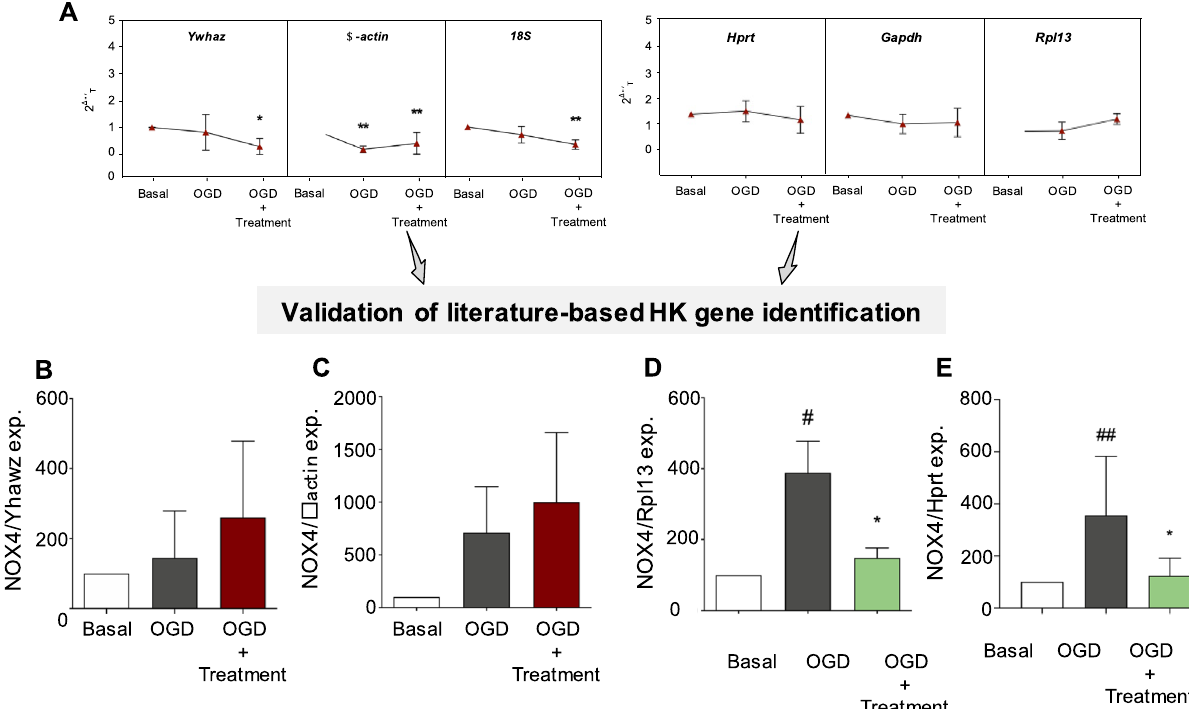
Figure 2. Opposing gene expression results are based on specific housekeeping gene selection. ( A ) HK gene validation using acute hippocampal brain slices (HBS) identified Yhawz , β -actin , and 18S as non-stable, while Hprt , Gapdh , and Rpl3 resulted in the best candidates for this model. ( B ) NADPH oxidase 4 ( Nox4 ) gene expression was assessed in HBSs subjected to 3 different experimental conditions, (i) basal, (ii) oxygen and glucose deprivation (OGD), and (iii) OGD under treatment conditions. Nox4 gene expression was normalised against previously detected unstable genes ( Yhawz , β -actin, and 18S ) and the most stable candidates ( Hprt, Gapdh, and Rpl13 ). Diametrically opposing results were identified depending on the selected HK gene ( # p < 0.05, ## p < 0.01 n = 5) later prevented by 2 h of pharmacological treatment ( *p < 0.05, n =